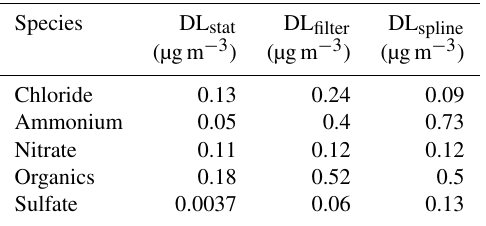
Table 1. Detection limits of the species measured by the ERICA- AMS determined with several methods. DL stat and DL filter mea- sured under lab conditions. DL spline measured during the Strato- Clim field campaign. The limits are given for one measurement cy- cle (10s) and are expected to reduce with longer averaging times t √ t proportionally to 1 /